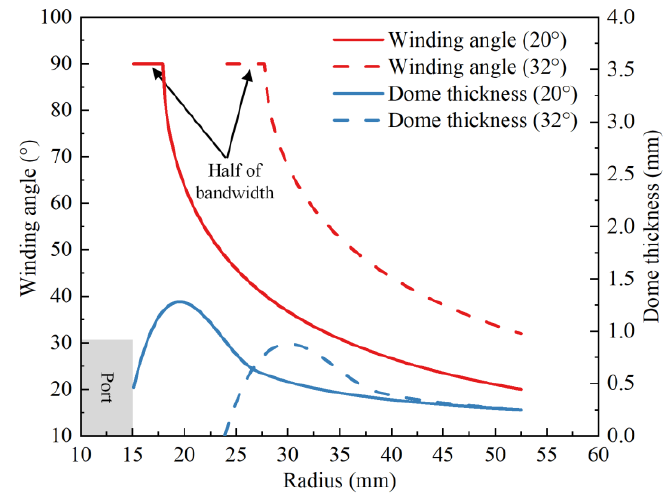
Figure 4. Analytical results of the variations of winding angle and dome thickness.